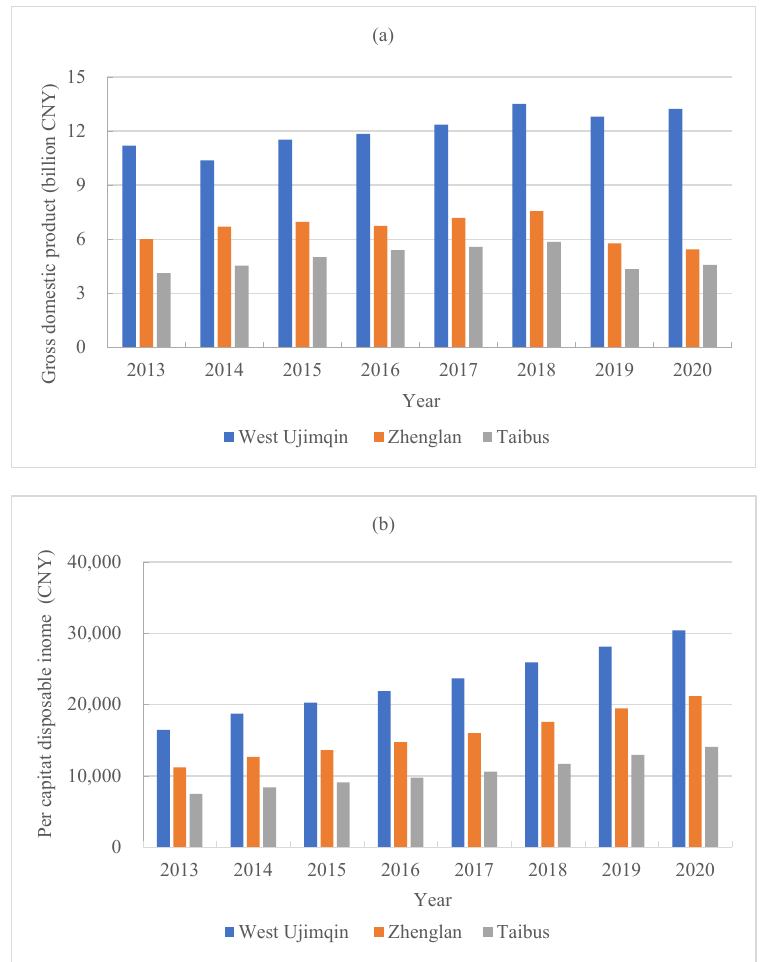
Figure A1. Gross domestic product ( a ) and per capita disposable income ( b ) of permanent residents of rural and pastoral areas in three Mongolia banners.